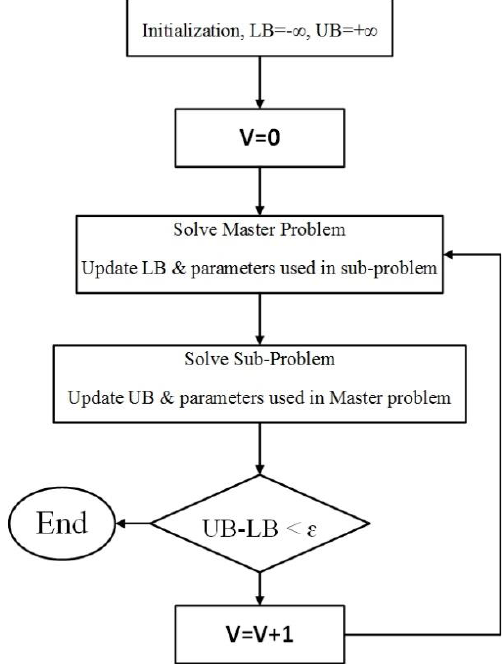
Figure 2. Solution procedure flow chart.